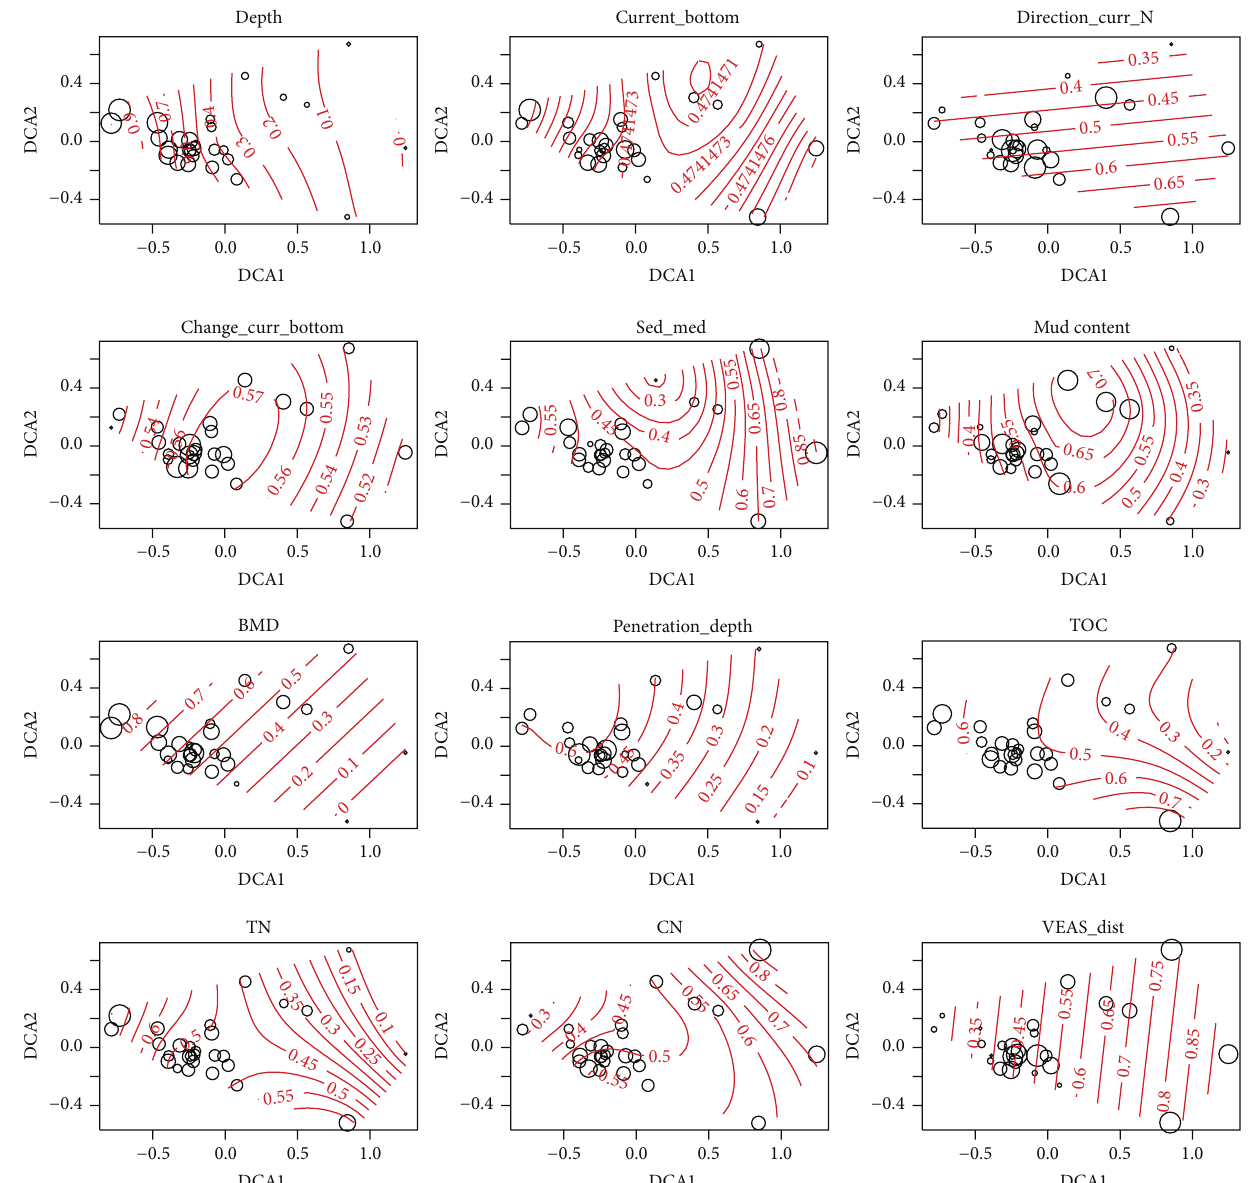
Figure 5: Contour-plots of selected environmental variables on DCA. 𝑅 32 , axes 1 and 2, showing patterns of variation in ordination space. The contour-plots are fitted by use of the ordisurf command fitting GAM with Gaussian errors. The size of the bubbles is proportional to the magnitude of the target value and are comparable between plots because environmental variables are ranged between 0 and 1. Axes are scaled in SD units of compositional turnover. The equidistance between contours differs between plots. See Table 2 for description of environmental